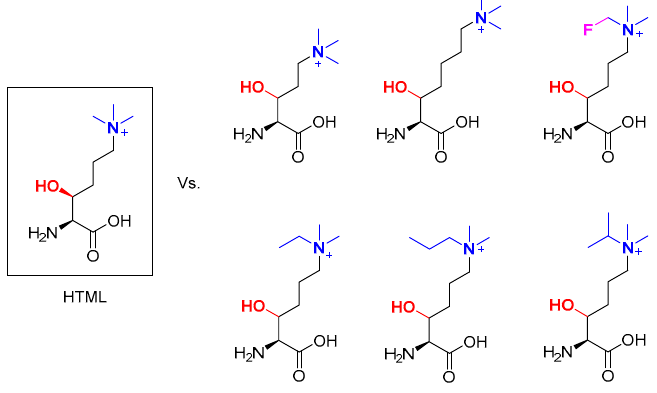
Figure 4. Kme3 analogues produced by trimethyllysine hydroxylase (TMLH).